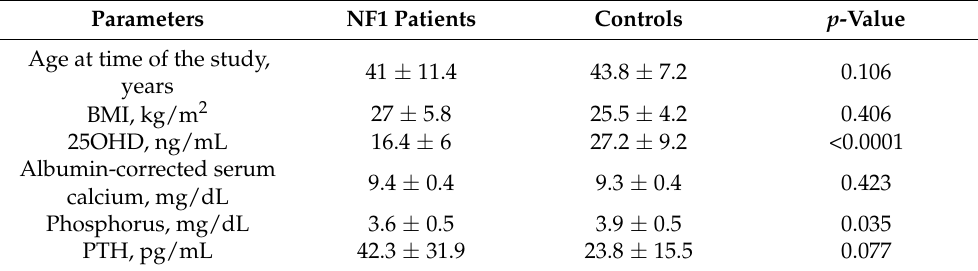
Table 1. Clinical characteristics and parameters involved in bone metabolism in patients with NF1 and matched